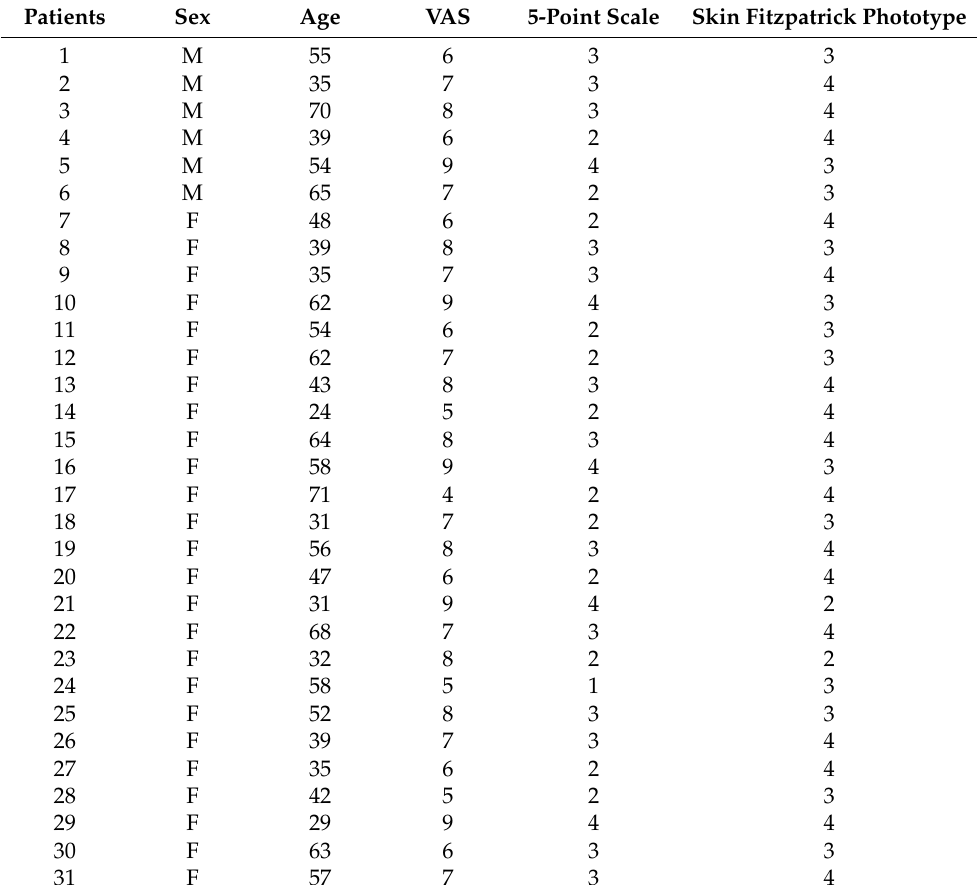
Table 1. Patients’